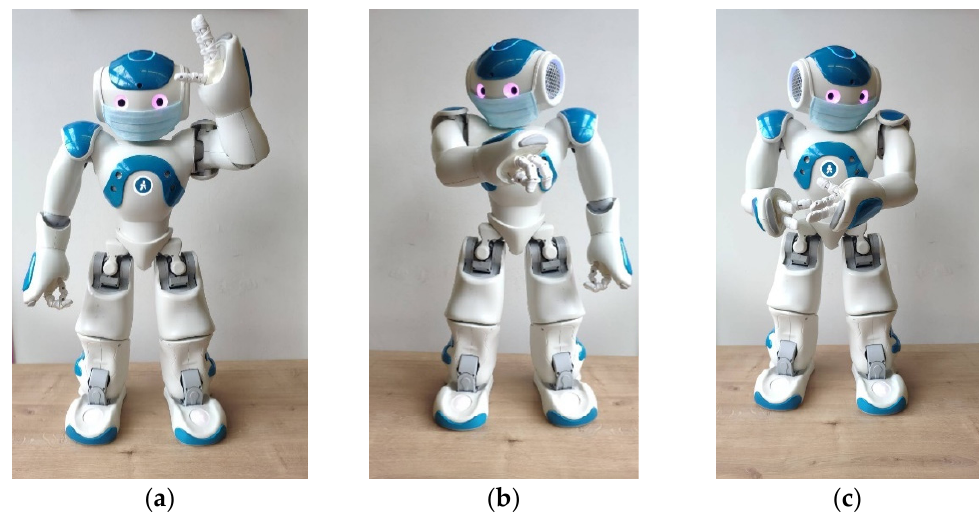
Figure 1. Examples of non-verbal behaviours. ( a ) Nao shows with its hands how to correctly wear a mask; ( b ) Nao sneezes on its elbow; ( c ) Nao shows how to clean hands.